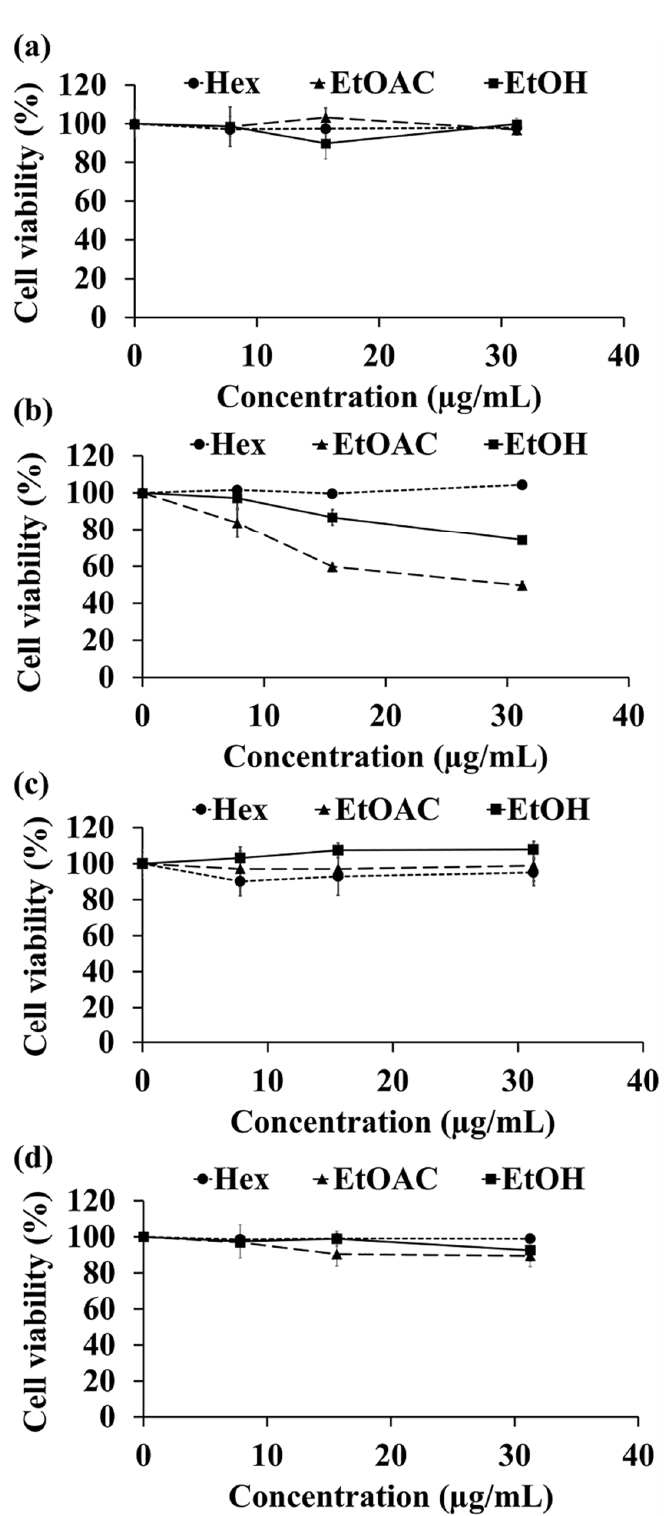
Figure 9. Effect of C. carandas extracts from leaf ( a ), seed ( b ), pulp ( c ), and fruit ( d ) which were sequentially extracted using n -hexane (Hex), ethyl acetate (EtOAc), and 95% ethanol (EtOH), respec- tively, on viability of HaCaT after treatment for 48 h. The cell viability of HaCaT was determined by MTT colorimetric technique.